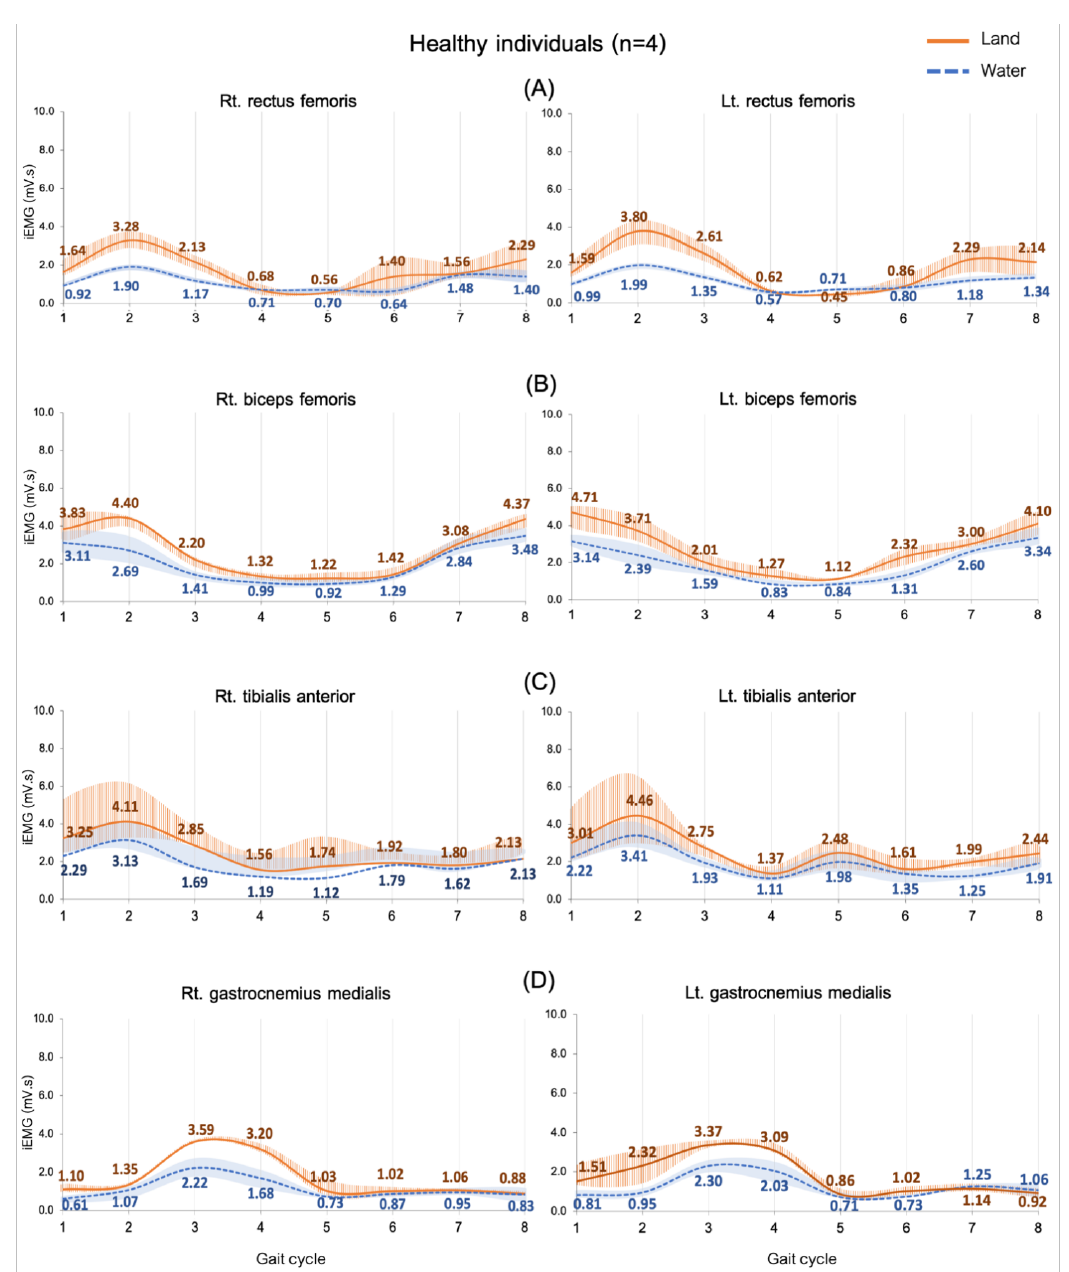
Figure 2. EMG activity while walking on land and in water in healthy individuals (n = 4). Rectus femoris, RF ( A ), biceps femoris, BF ( B ), tibialis anterior, TA ( C ), and gastrocnemius medialis, GM ( D ). Gait phases: 1 = initial contact, 2 = loading response, 3 = mid stance, 4 = terminal stance, 5 = pre swing, 6 = initial swing, 7 = mid swing, and 8 = terminal swing.